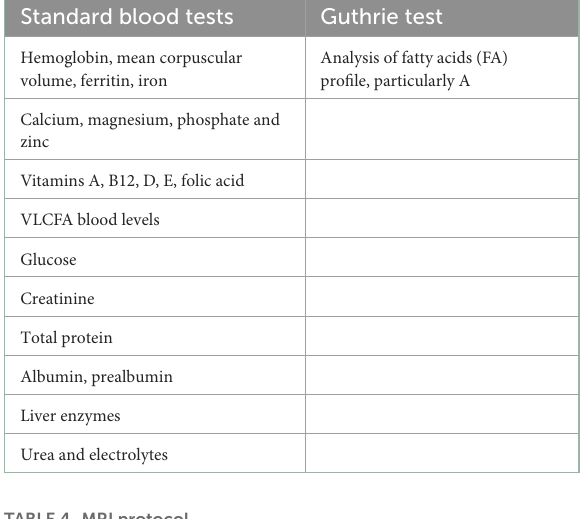
TABLE 4 MRI protocol.